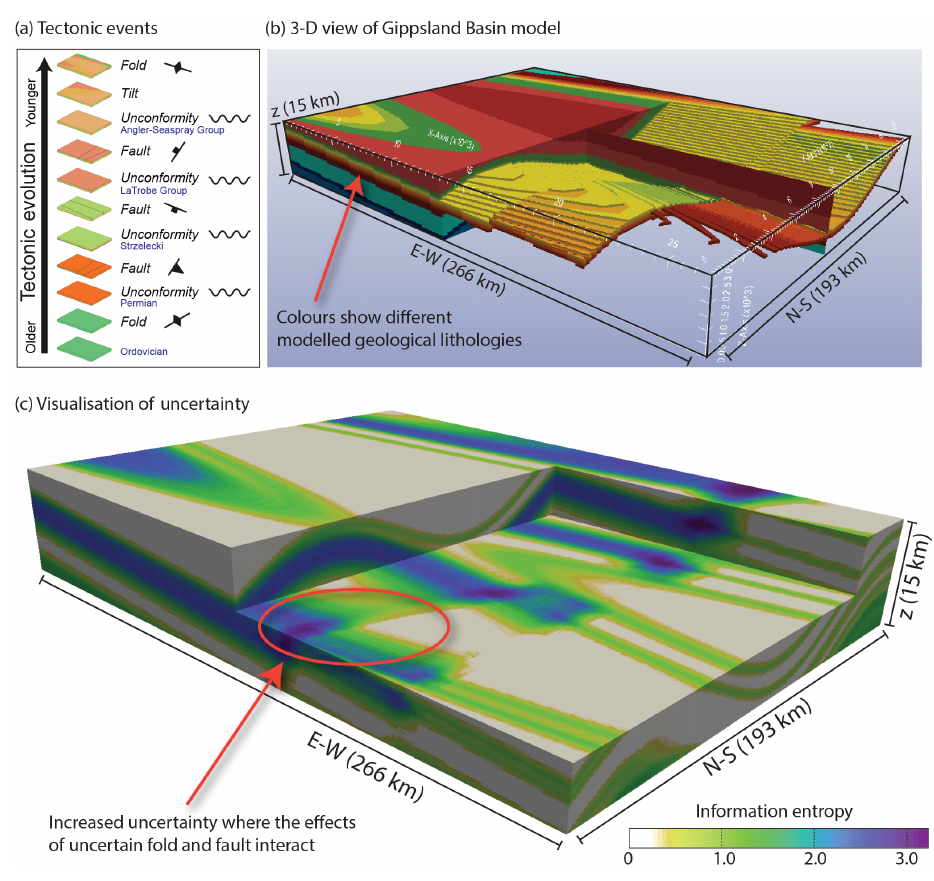
Figure 6. (a) Tectonic events in the kinematic model. Symbols indicate main orientation of events, stratigraphic units in blue font; (b) 3- D visualization of simulated block model (transparency for better visualization of internal fold), colours indicate geological lithologies; (c) Visualization of uncertainty with information entropy, clearly visible are high uncertainties where effects of uncertain fold and fault